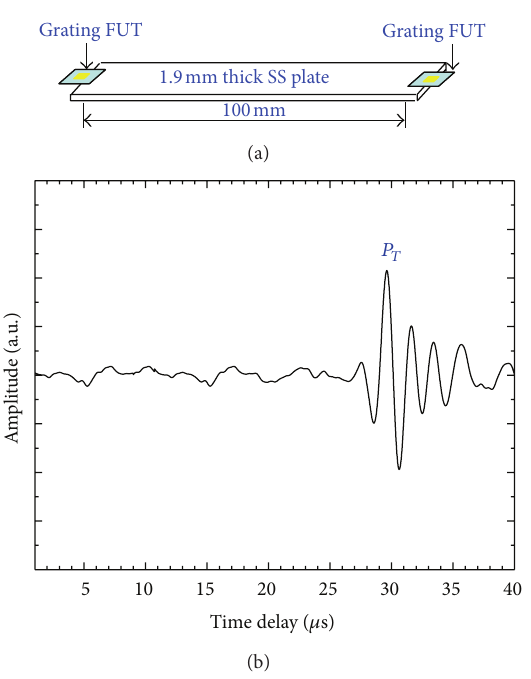
Figure 12: (a) Flexible grating transducers shown in Figure 10 are bonded at two ends of a 1.9 mm thick stainless steel plate. (b) Ultrasonic performance obtained by operating the two grating transducers in transmission mode.